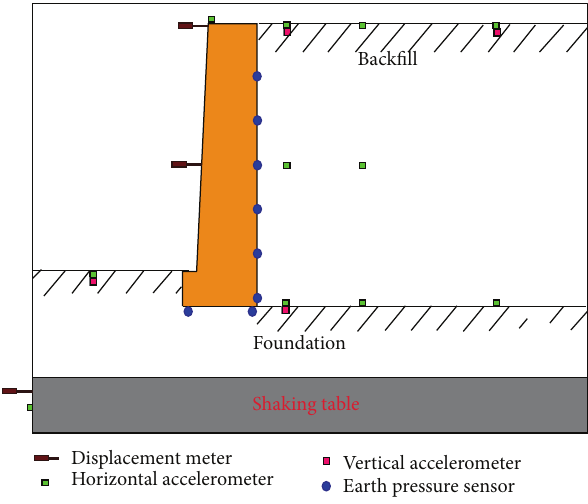
Figure 4: The instrument configuration.